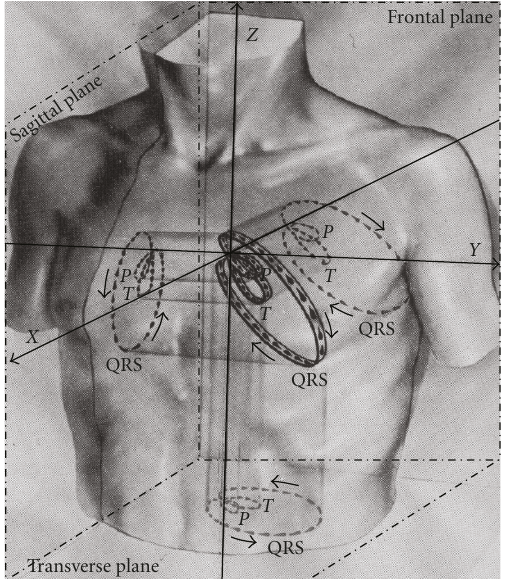
Figure 3: The VCG loop and its projection onto the three orthogonal planes [5].